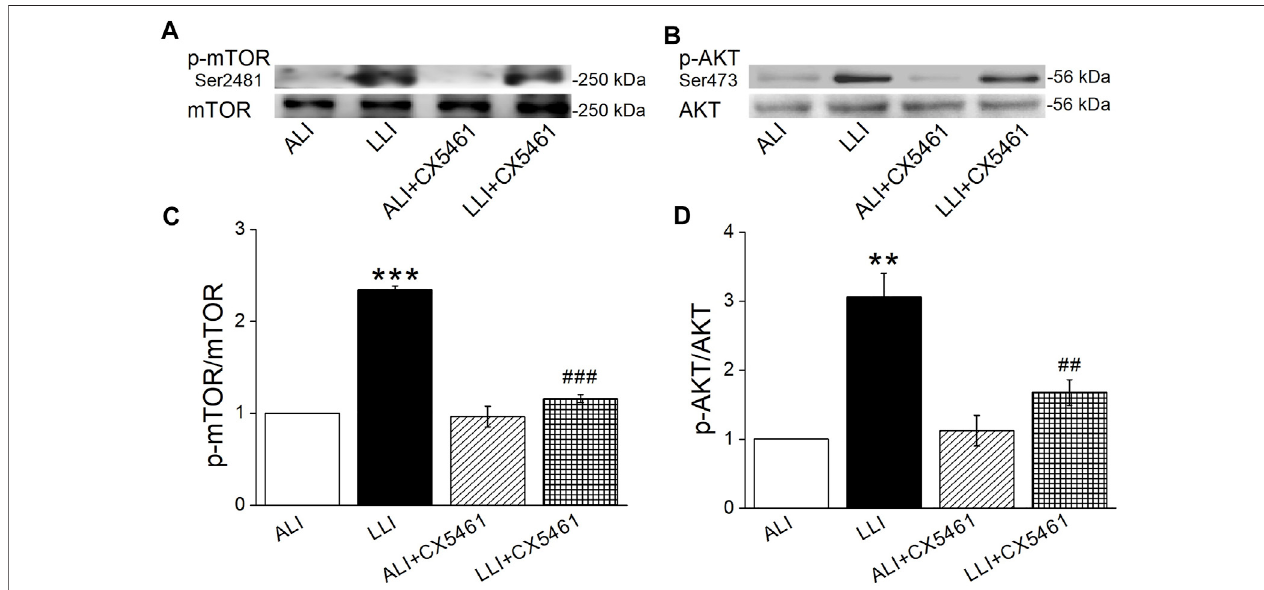
FIGURE7| EffectofCX-5461 downstream ofribosome. (A,C) Representativeandstatistical dataofmTORphosphorylationatSer2481after CX-5461 treatment. (B, D) Representative and statistical data of AKT phosphorylation at S473 after CX-5461 treatment. *** p < .001 compared with ALI group, ### p < .001, compared with LLI group, n (cid:1) 3 – 4. One-way ANOVA followed by Bonferroni ’ s test was used to analyze the difference of the means for signi fi cance.